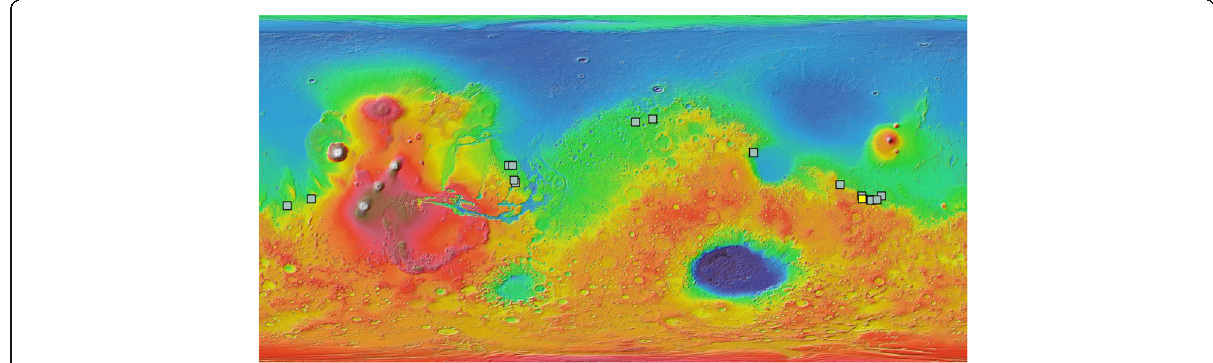
Fig. 3 MOLA topography of the low-laying northern plains of Mars with white squares showing remnants of 17 deltaic deposits identified by Di Achille and Hynek (2010). The yellow square indicates the location of Aeolis Mensae